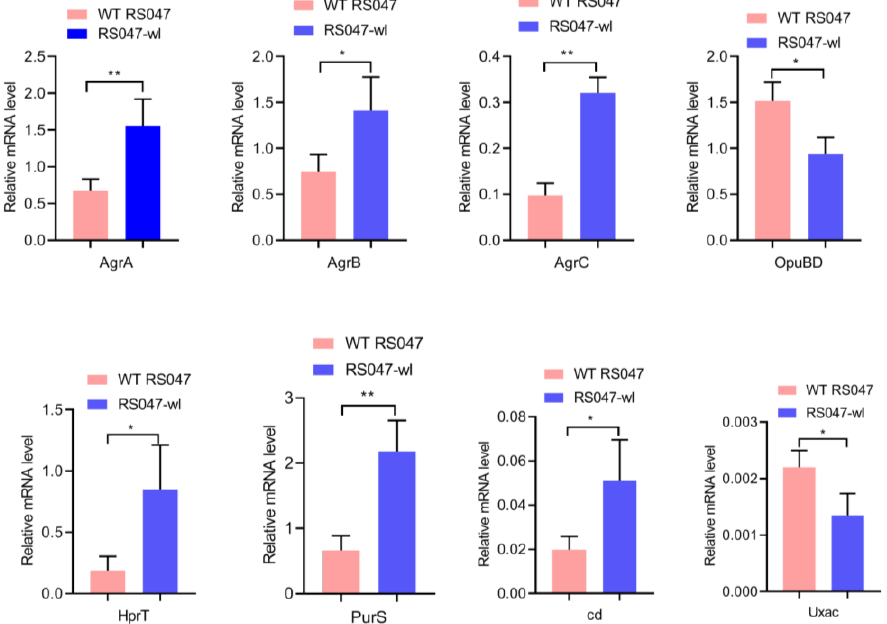
Figure 7. PCR amplification results of the differential expression genes between WT RS047 and RS047-wl. The expression of the genes analyzed was normalized to their expression levels in the corresponding control group. Data are represented as mean ± SEM of at least three independent experiments. * p < 0.05, ** p < 0.01.